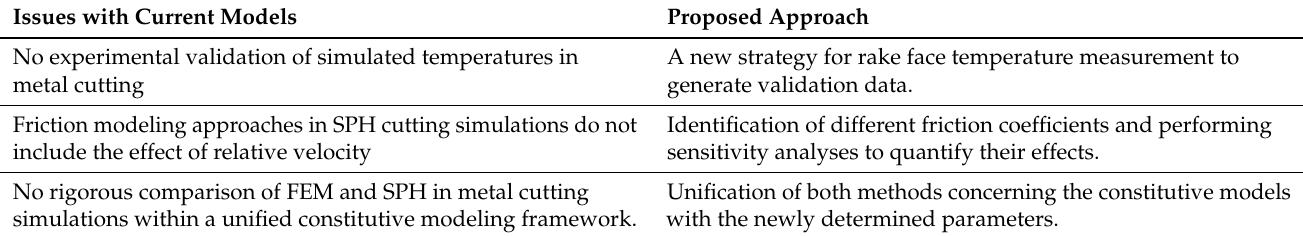
A new strategy for rake face temperature measurement to generate validation data. Identification of different friction coefficients and performing sensitivity analyses to quantify their effects. Unification of both methods concerning the constitutive models with the newly determined